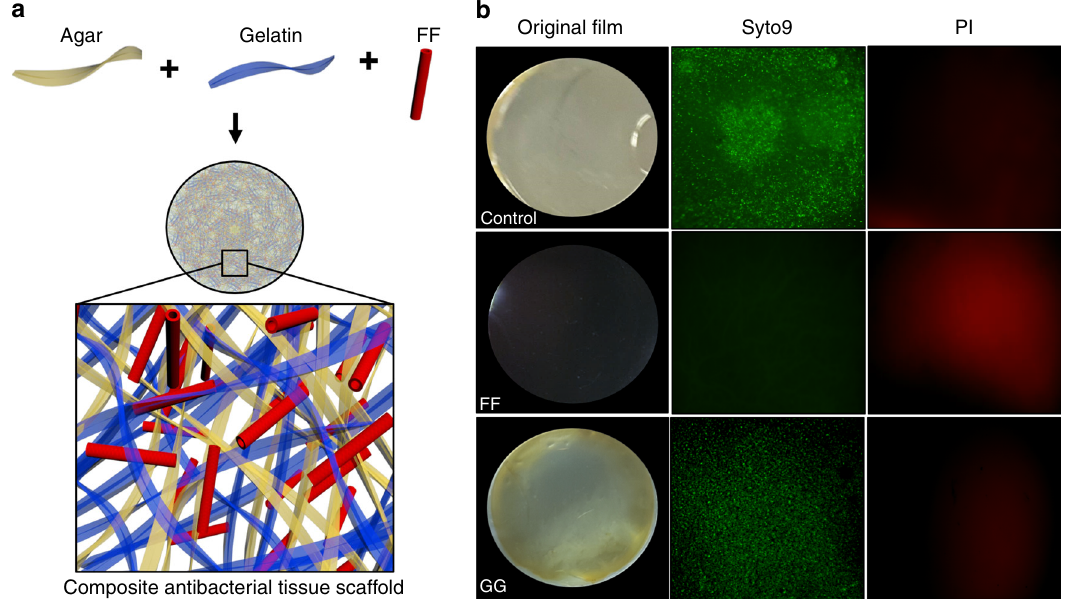
Fig. 5 Development of diphenylalanine nanostructure incorporated composite antibacterial tissue scaffolds. a Model of the composite diphenylalanine nanostructure incorporated antibacterial tissue scaffolds. b Incorporation of diphenylalanine nanostructures into the agar-gelatin tissue scaffold completely hinders growth of bacteria on the scaffold. Bacterial growth was evaluated by turbidity and by Live/Dead bacterial viability